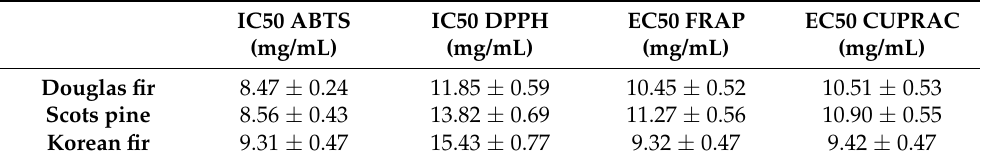
Table 3. Antioxidant activities expressed as IC50 (for ABTS and DPPH tests) and EC50 (for FRAP and CUPRAC assays). IC50